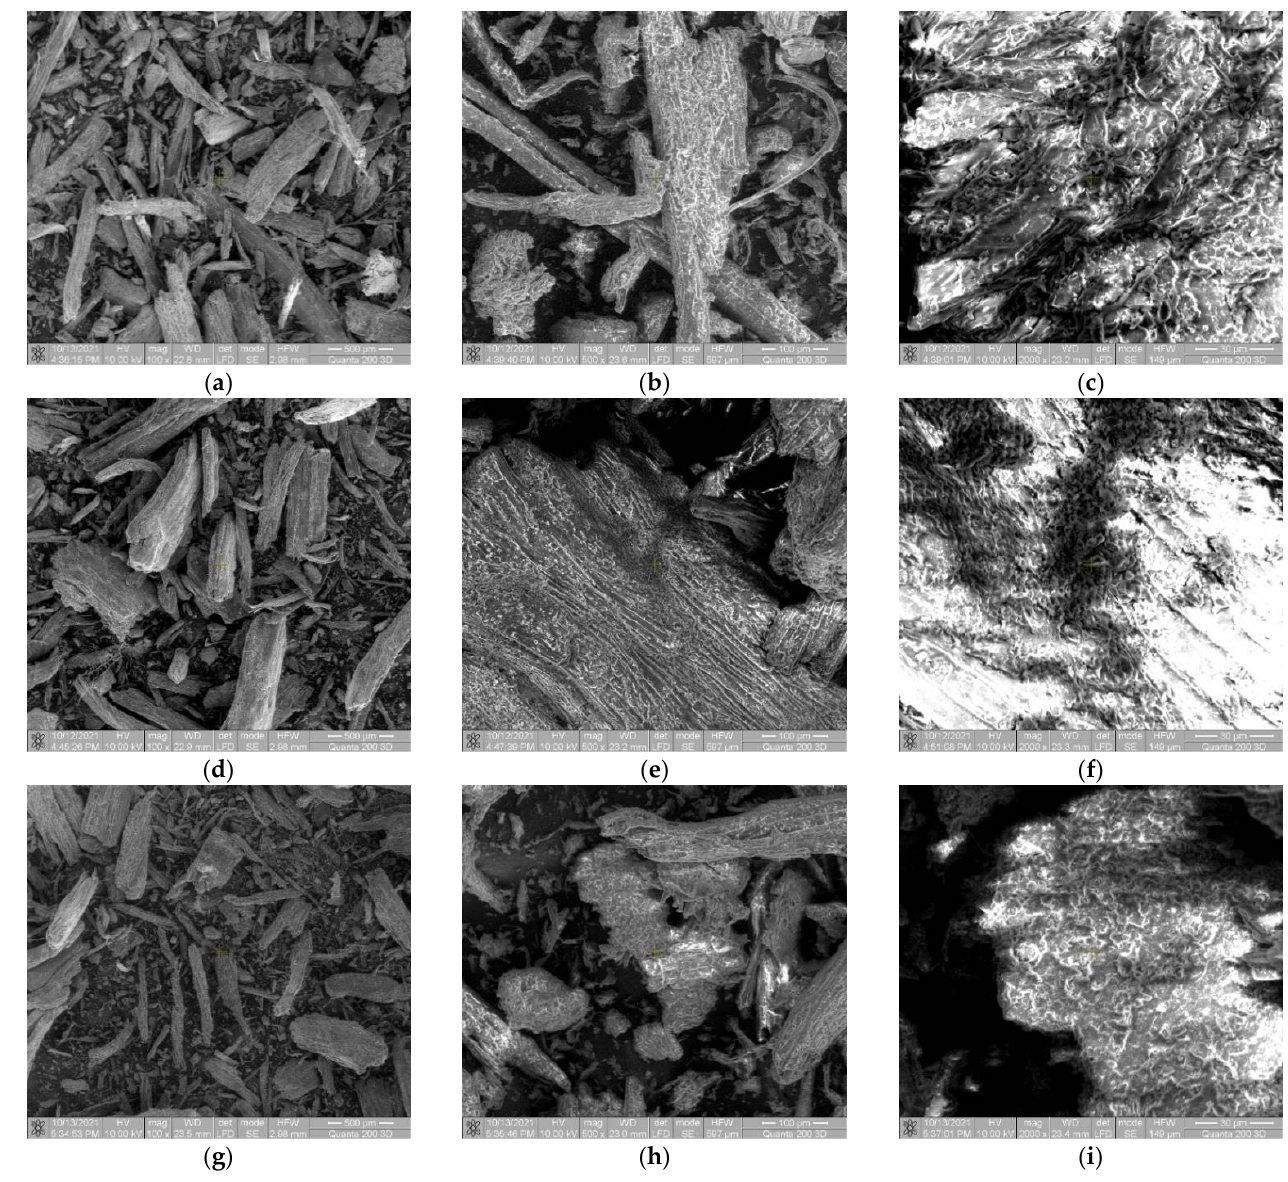
Figure 2. SEM images of shredded wood biomass at various magnitudes: ( a ) apricot—100×; ( b ) apricot—500×; ( c ) apricot—2000×; ( d ) peach—100×; ( e ) peach—500×; ( f ) peach—2000×; ( g ) plum— × ; ( c ) apricot—2000 × ; ( d ) peach—100 × ; ( e ) peach—500 × ; ( f ) peach—2000 × ; 100×; ( h ) plum—500×; ( i ) plum—2000×. ( b ) apricot—500 ( g ) plum—100 × ; ( h ) plum—500 × ; ( i ) plum—2000 ×